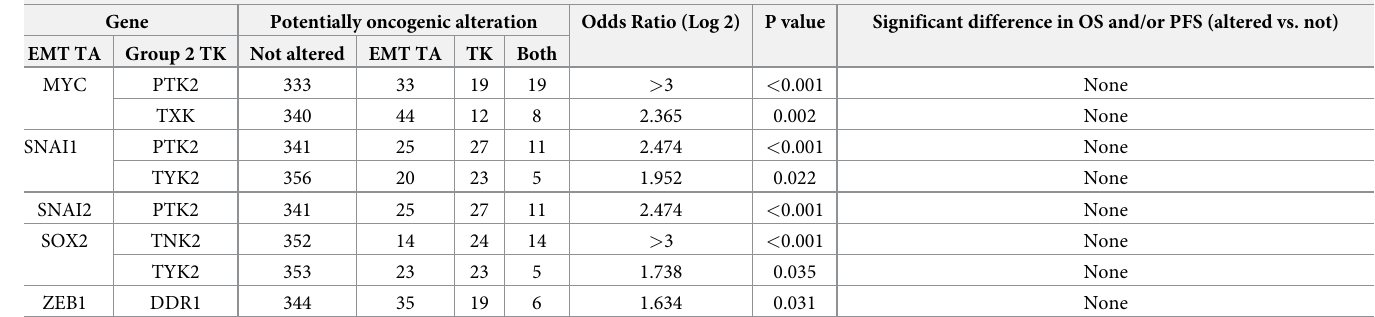
significantly increased 5637 and J82 cell proliferation rates, and cabozantinib treatment signifi- cantly inhibited proliferation by these lines below the rate of untreated cells, in the presence or absence of added Gas6 (Fig 6C). In FL3 cells, added MST1 alone significantly increased prolif- eration rate, and cabozantinib treatment alone significantly reduced proliferation rate, relative to untreated cells (Fig 6D). But unlike Gas6-driven proliferation in 5637 and J82 cells, treat- ment with both cabozantinib and MST1 reduced FL3 proliferation to the control cell growth rate, but not below (Fig 6D). Autocrine-driven proliferation by the AXL , MST1R and CSF1R pathways in J82 and FL3 cells was further supported by studies in which siRNA suppression of ligands or RTKs (Fig 7A) was exerted in the presence or absence of exogenous ligand and/or cabozantinib (Fig 7B–7D). Consistent with the results of biochemical and cell migration stud- ies, J82 cells transfected with siRNA directed against GAS6 or AXL showed significantly reduced proliferation relative to control siRNA transfected cells (Fig 7B), as did FL3 cells trans- fected with siRNA directed against MST1 , MST1R , CSF1 , or CSF1R (Fig 7C and 7D). Anchor- age independent growth by J82 (Fig 7E) and FL3 (Fig 7F) was similarly enhanced significantly by added ligand, inhibited by cabozantinib treatment, and suppressed by RTK-directed siRNA.